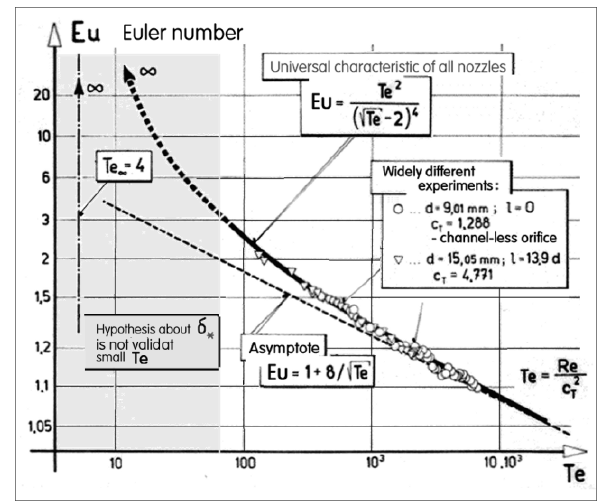
Fig. 10. Author‘s universal characteristic of all nozzles compared with two extreme cases, the shortest and the longest nozzle for which were by the author accumulated experimental pressure loss data.